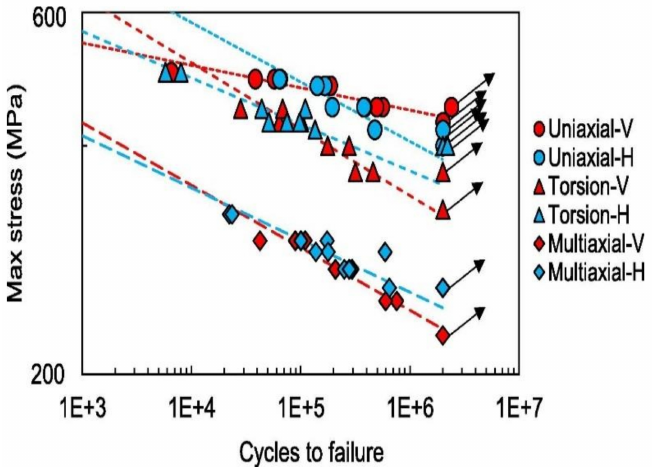
Figure 31. Comparison of all experimental data for ER70S-6 WAAM specimens under different fatigue load types. Reprinted with permission from ref. [73]. 2022, Elsevier.